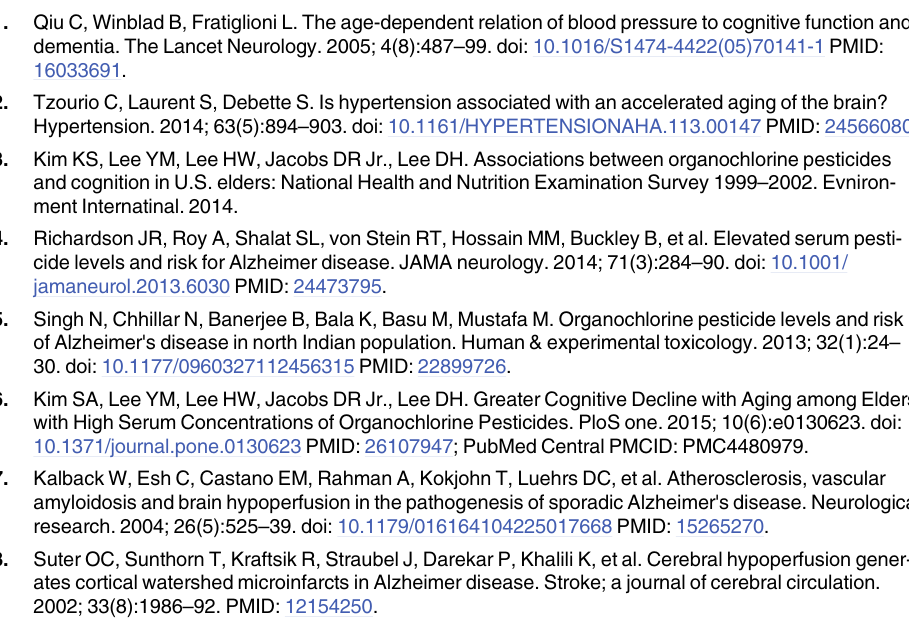
S1 Fig. Associations of hypertension (HTN) and summary measure of organochlorine (OC) pesticides with the risk of low cognitive score. Different from Fig 1, adjusted odds ratios were estimated after considering the design variables and sample weight of National Health